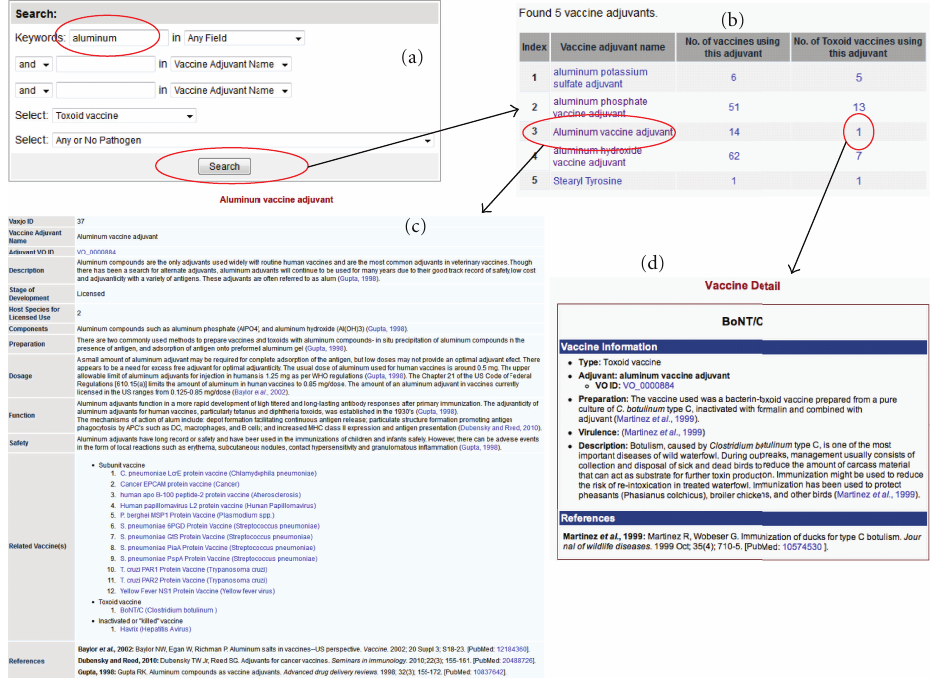
Figure 4: An example of searching a vaccine adjuvant and its related information in Vaxjo. (a) The keyword “aluminum” is queried in Vaxjo. (b) The adjuvants resulting from the Vaxjo keyword search. (c) The Vaxjo page obtained by clicking on “Aluminum vaccine adjuvant” in (b). The Vaxjo page for the adjuvant has information about the adjuvant (alternate names, components, function, etc.) and lists vaccines in which the adjuvant is used, as well as references. (d) The vaccine page obtained by clicking on the vaccine number shown in (b). This web page shows the details about this